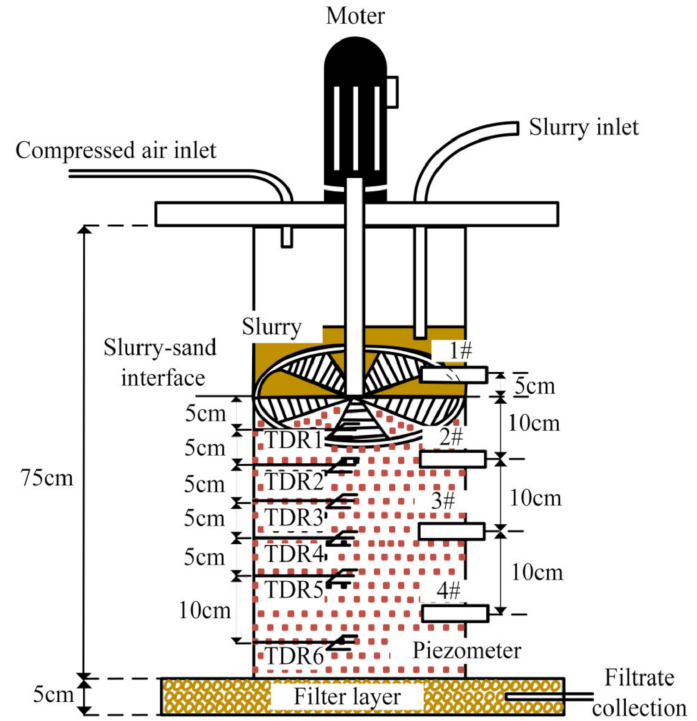
Figure 7. The dimensions of the test apparatus and measurement